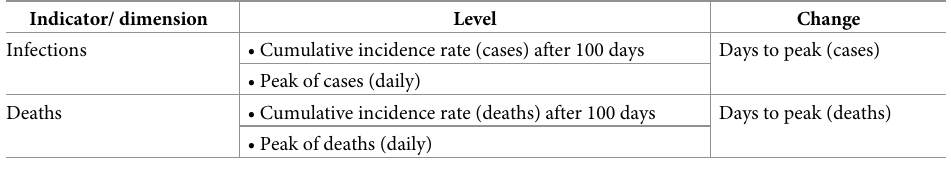
Table 1. Indicators, dimensions, and dependent